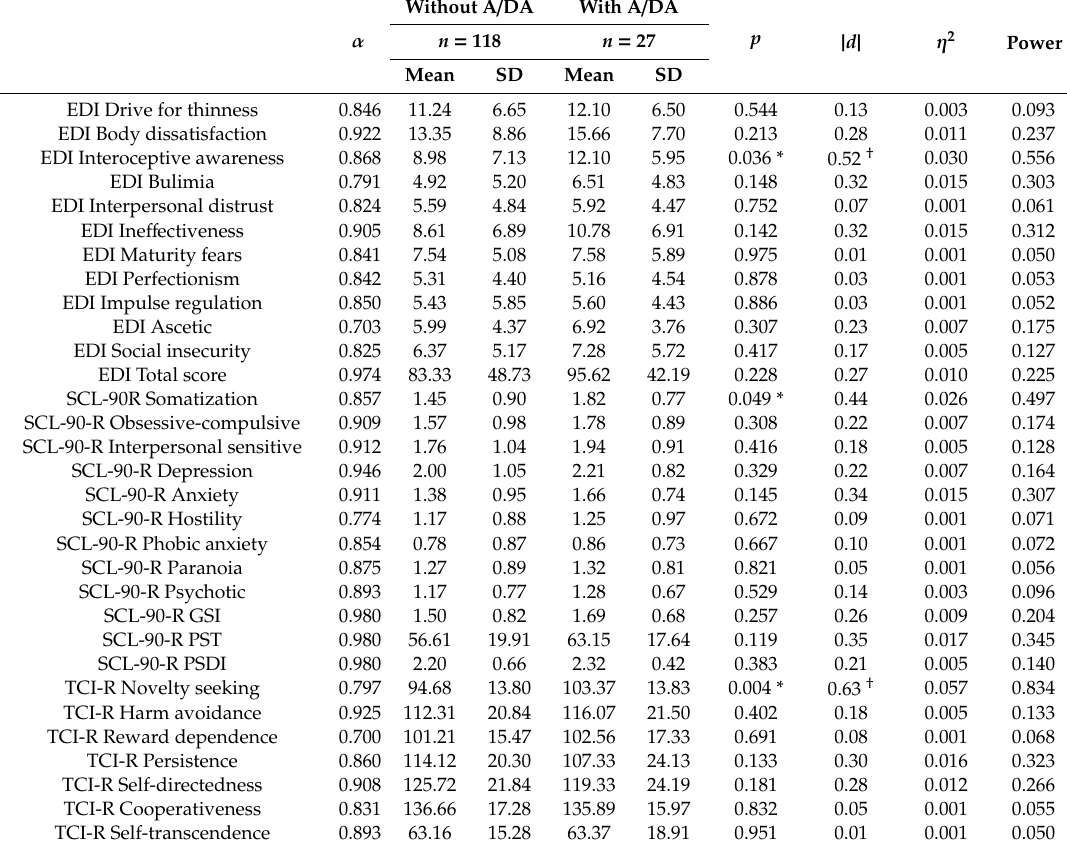
Table 3. Comparison of the clinical profile between groups with and without A /